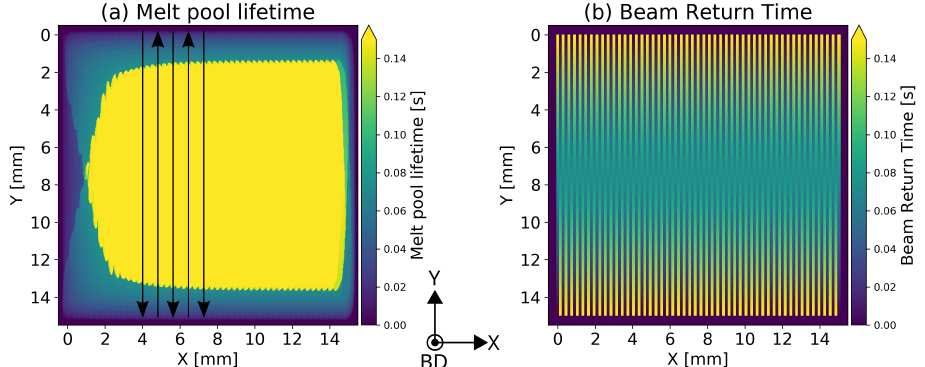
Figure 1. Approach for the determination of the persistent areas of the melt pool: ( a ) maximum melt pool life time at each position of the hatch; ( b ) local beam return times. Black arrows indicate beam movement along the scanning vectors according to the cross snake hatching strategy. Lateral movement of the beam from left to